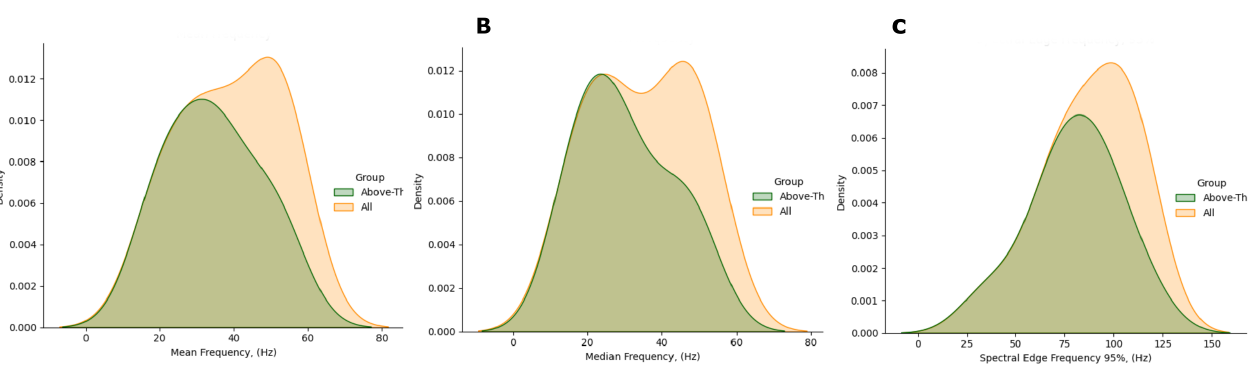
Figure 7. Comparison of the spectral features distribution plots, as regards all HS (yellow) and HS with RAI above threshold (green). ( A ) Mean Frequency, ( B ) Median Frequency, ( C )